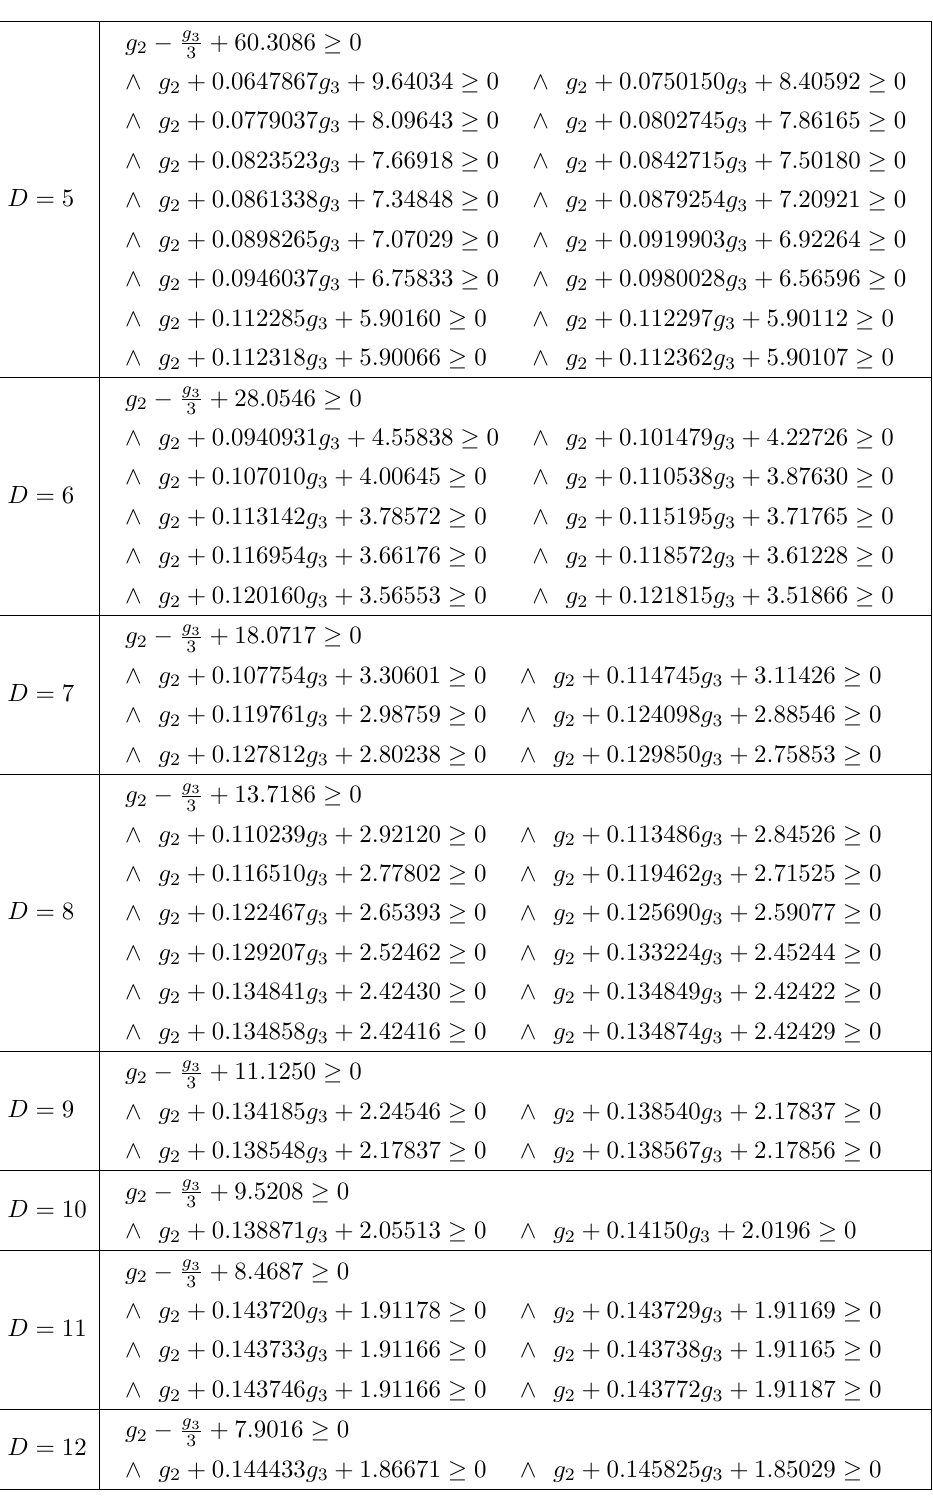
Table 3 . The inequalities plotted in figure 4 (in units where 8 πG = 1 and M = 1